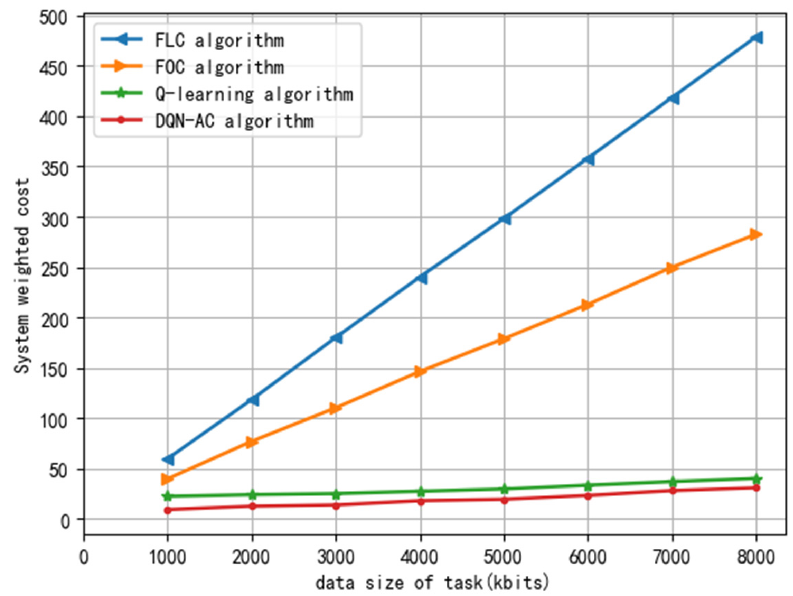
Figure 5. The impact of data size of task on system weighted cost.